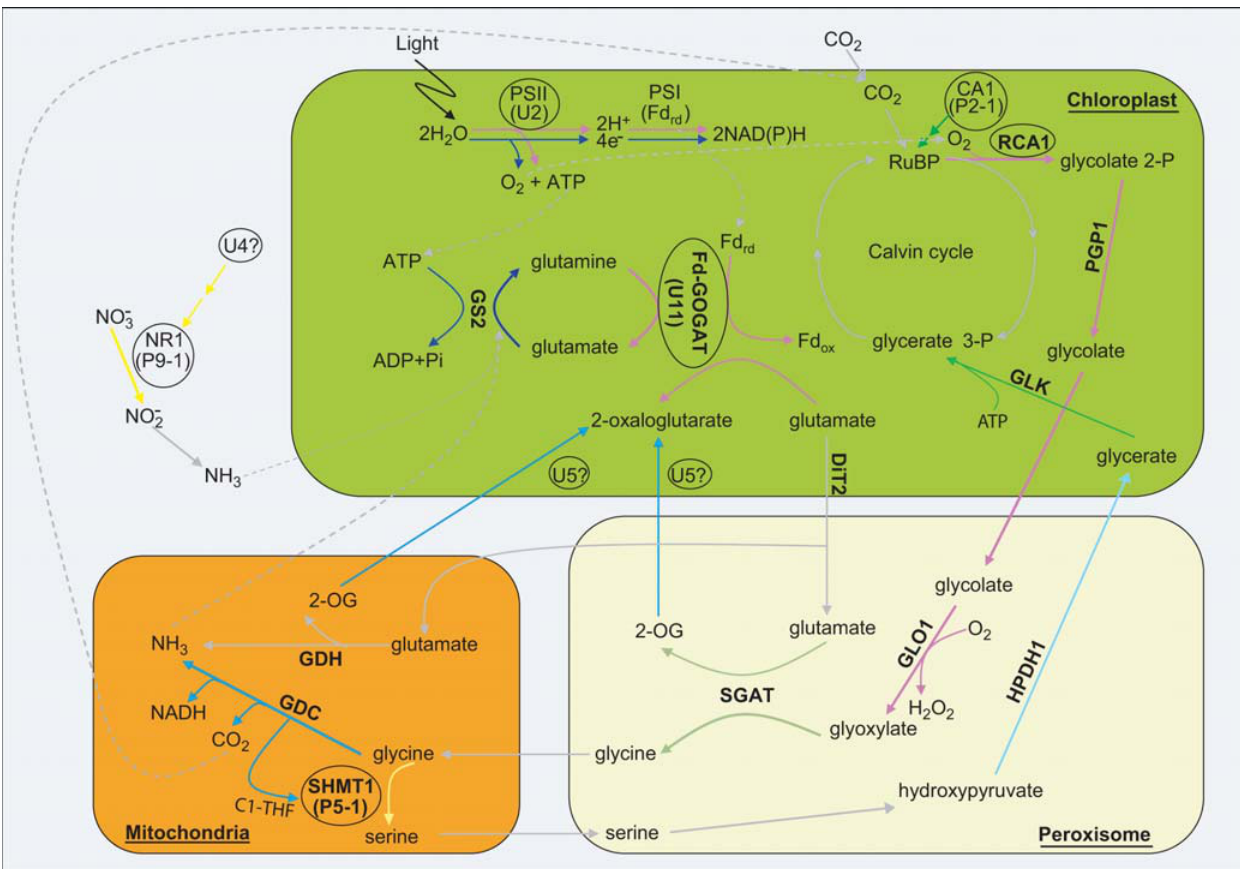
Figure 5. Schematic Representation of the Role of Rca1, Shmt1, U4, U5, Nr1, Ca1, and Psb28 in Photorespiration, Ammonia Assimilation, Nitrate Assimilation, and Photosynthetic Light Reaction Pathways. Photorespiration occurs in three organelles: the chloroplast, the peroxisome, and the mitochondria. Ammonia association pathway is tightly linked to photorespiration for recycling ammonia, byproduct of photorespiration. Rubisco activase 1 (Rca1) commits photorespiration by helping to incorporate O 2 to active site of ribulose bisphosphate carboxylase/oxygenase (RUBISCO) and ribulose bisphosphate (RuBP) is oxidized to 3-phosphoglycerate (glycerate 3-P) and 2- phosphoglycolate (glycolate 2-P). Then, glycolate 2-P is converted to glycine by a series of reactions: 2-phosphoglycolate phosphatase1 (PGP1), glycolate oxidase (GLO1) serine-glyoxylate aminotransferase (SGAT). The decarboxylation of two glycines produces serine, CO 2 and NH 3 by glycine decarboxlasse complex (GDC) and serine hydroxymethyltransferase 1 (SHMT1, P5-1). In addition, gulatamate dehydrogenase (GDH) in mitochondria deaminates glutamate and generates 2-oxoglutarate (2-OG) and NH 3 needed for ammonia assimilation (GS2/Fd-GOGAT cycle). SGAT also generates 2-OG from glutamate. Glutamate is supplied from chloroplast by glutamine synthase 2 (GS2) and ferredoxin dependant glutamine-oxoglutarate aminotransferase (Fd-GOGAT, U11) in ammonia assimilation, and glutamate/malate transporter (DiT2). Function of U5 gene product is suggested to transport 2-oxoglutarate to chloroplast. Serine is further converted to 3-phosphoglycerate by hydroxypyruvate dehydrogenase (HPDH1) and glycerate kinase (GLK). Photorespiration consumes CO 2 and energy (ATP) in photosynthetic cells. Photosynthetic light reaction carried out by photosysntem I (PSI) and photsystem II (PSII, U3) supplies O 2 , ATP and reduncing powers (reduced ferredoxin form, Fd rd ). Nitrate (NO 3 2 ) is another source of nitrogen for plant growth and nitrate assimilation pathway is alternative way to provide ammonia for GS2/Fd-GOGAT cycle. Nitrate reductase 1 (NR1, P9-1) commits this pathway. U4 is suggested to have roles in transcriptional regulation of nitrate assimilation pathway. Glycerate 3- P resulted from photorespiration goes into Calvin cycle for the CO 2 fixation. Carbonic anhydrase 1 (CA1, P2-1) might be involved in CO 2 fixation in RuBP. Black circles indicate the steps in the pathway which are related to mutants identified in this study. Question marks (?) indicate genes of unknown function ( U4 and U5 ). Purple lines indicate genes belonging to co-expressed cluster III; blue, cluster IV; yellow, cluster V; bright blue, cluster VIII; pure cyan, cluster IX; and dried sage, cluster X in Figure 4. Weak gray lines indicate steps in each pathway not associated with data collected in this study.